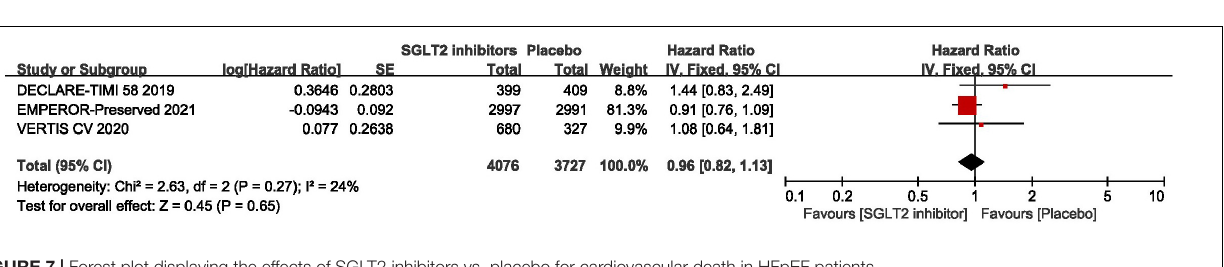
FIGURE 7 | Forest plot displaying the effects of SGLT2 inhibitors vs. placebo for cardiovascular death in HFpEF patients.